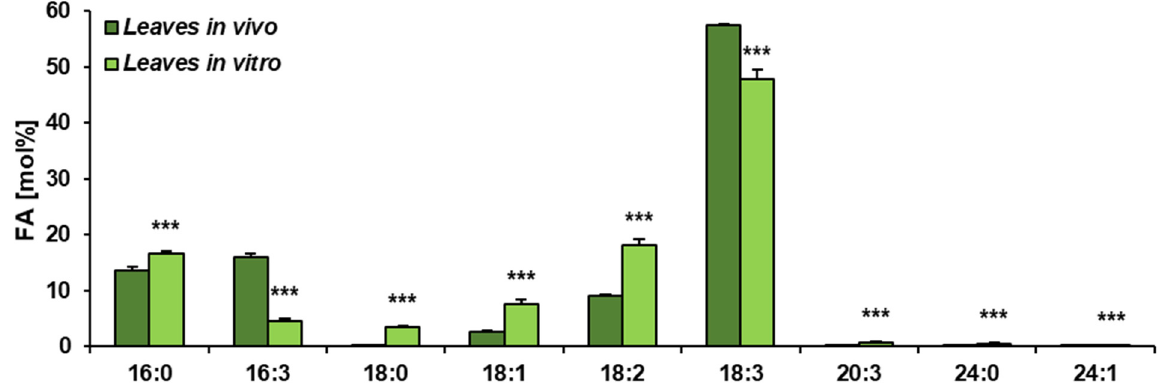
Figure 2. Fatty acid composition of acyl-lipids present in C. sativa leaves cultured in in vivo and in vitro conditions. Mean values and SD are presented (data from at least three independent assays). Asterisks indicate significant difference between relative amounts of each fatty acid of acyl-lipids in leaves cultivated in vivo and in vitro in a two-tailed Student’s t -test: *** p ≤ 0.001.